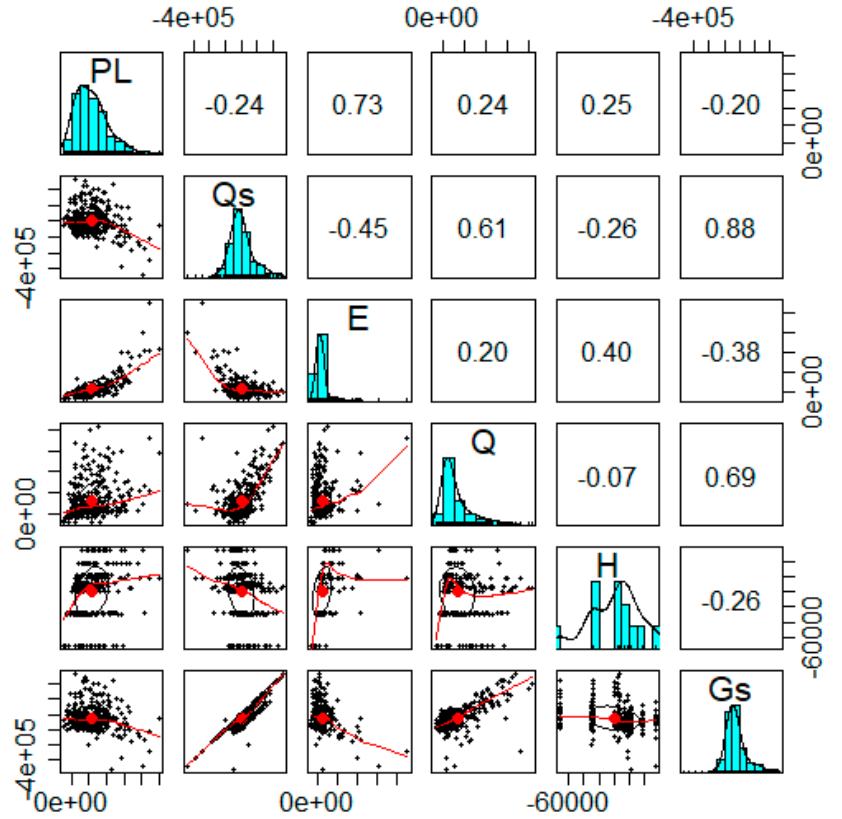
Figure 5. Correlogram of multicollinearity between the main water balance components adjusted for seasonality. Graphs in the diagonal, plots below the diagonal, and numerical values above the diagonal.